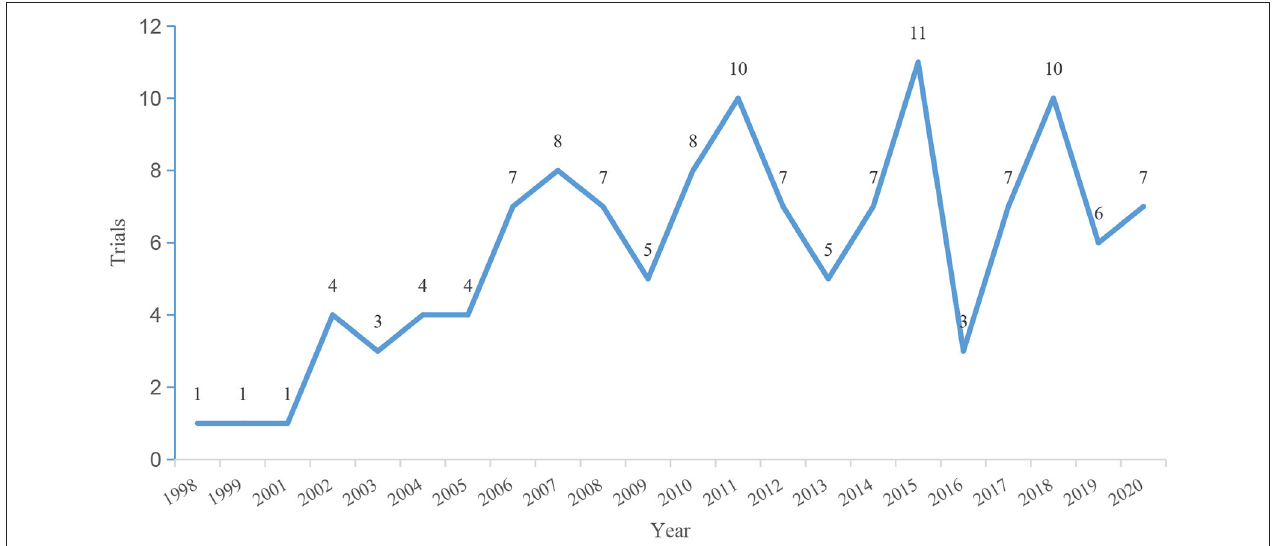
FIGURE 1 | Quantity trend of registered trials per year.